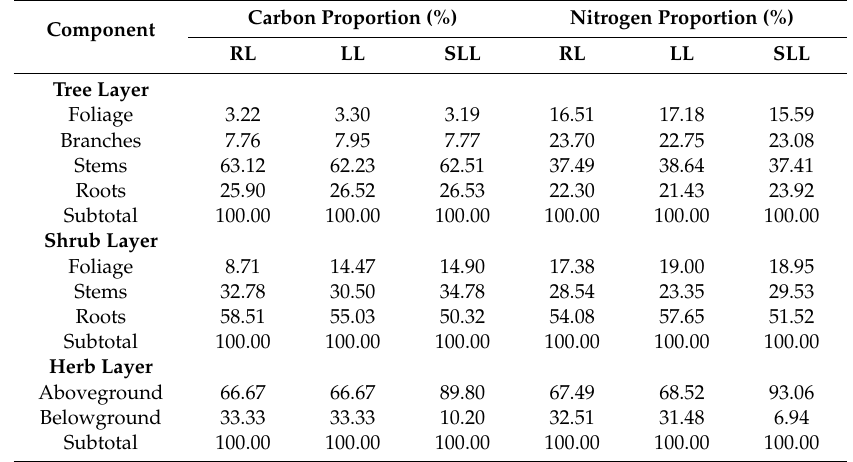
Table 5. Carbon and nitrogen distributions in the vegetation